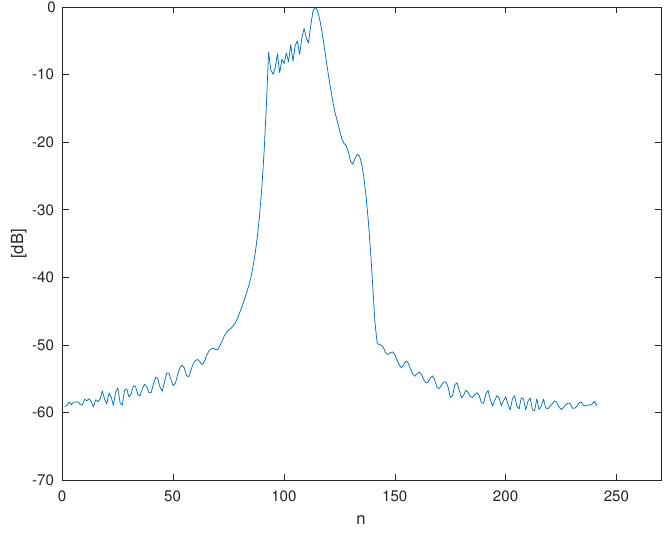
Figure 12. Spectrum of the reduced field F ( ξ ) in the case that the antenna is not centered in the reference